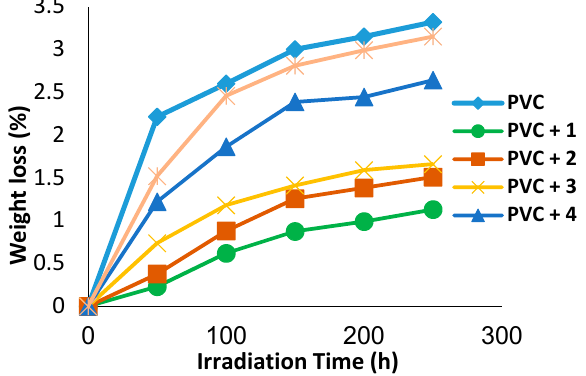
Figure 6. The relationship between the irradiation time (h) and weight loss (%) for PVC films (30 μ m thickness) with Schiff’s bases 1 – 5 (0.5% by weight) as additives.